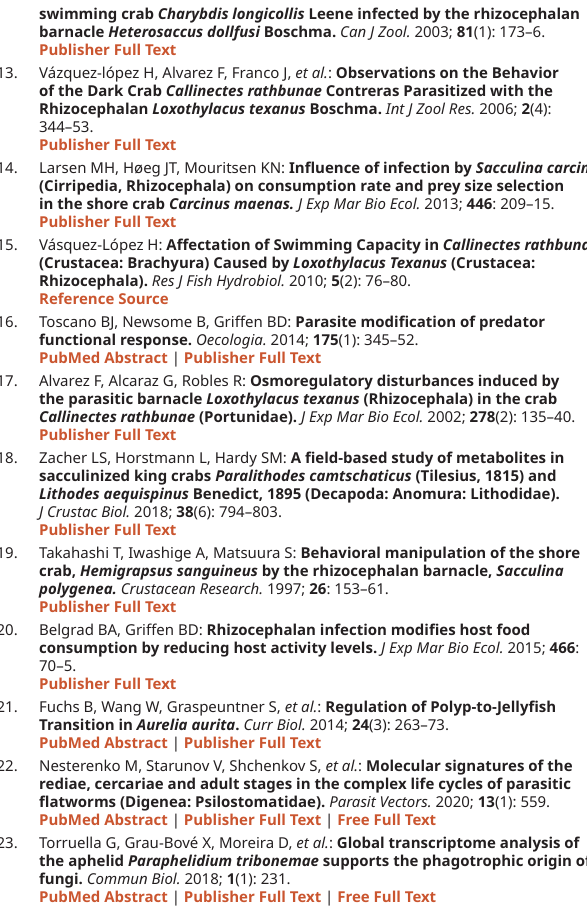
Figshare: Table S4. Gene Set Enrichment Analysis (GSEA) results for the molecular signatures and sets of over-expressed genes, https://doi.org/10.6084/m9.figshare.19307570 74 Figshare: Table S5. Potential excretory/secretory proteins analysis results, https://doi.org/10.6084/m9.figshare.19307594 75 Figshare: Table S6. Phylostratigraphic affiliation analysis results for different set of sequences, https://doi.org/10.6084/